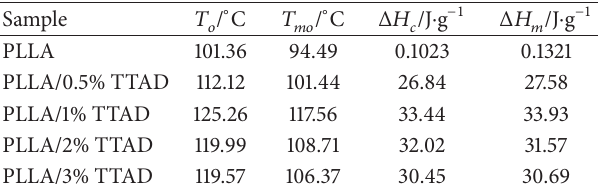
Table 2: DSC date of PLLA and PLLA/TTAD crystallized from the melt at cooling rate of 1 ∘